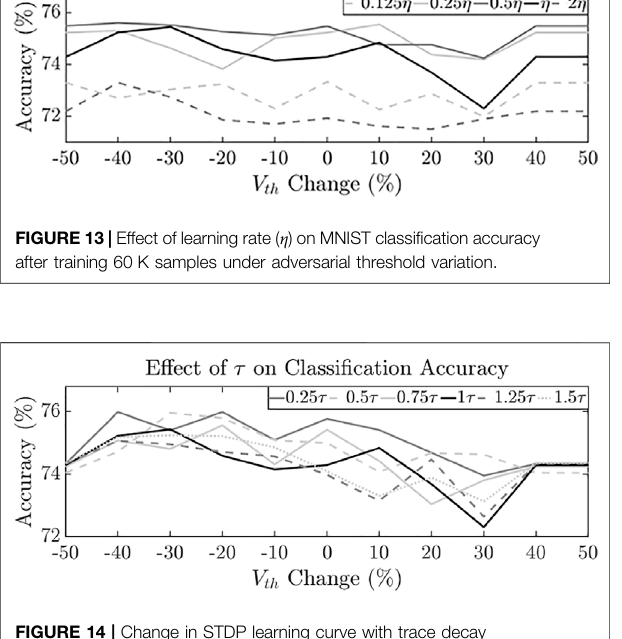
FIGURE 14 | Change in STDP learning curve with trace decay constant ( τ ).